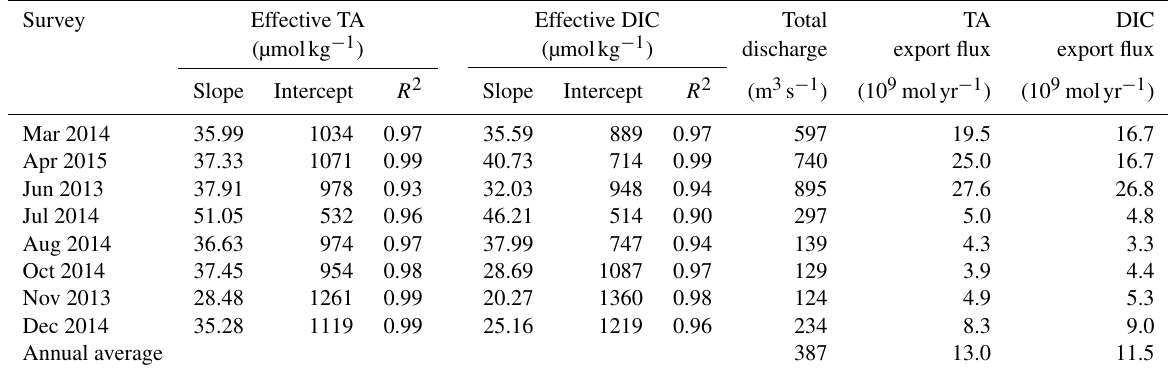
Table 3. Effective TA and DIC as a function of salinity, calculated by linear regression using data from high-salinity waters in the Delaware Estuary and their export fluxes to the ocean. Survey Effective TA Effective DIC